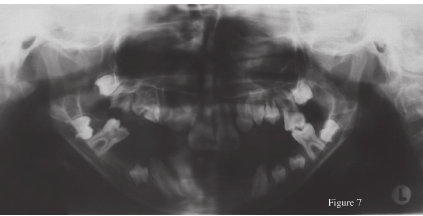
Figure 7: Panoramic radiograph of the